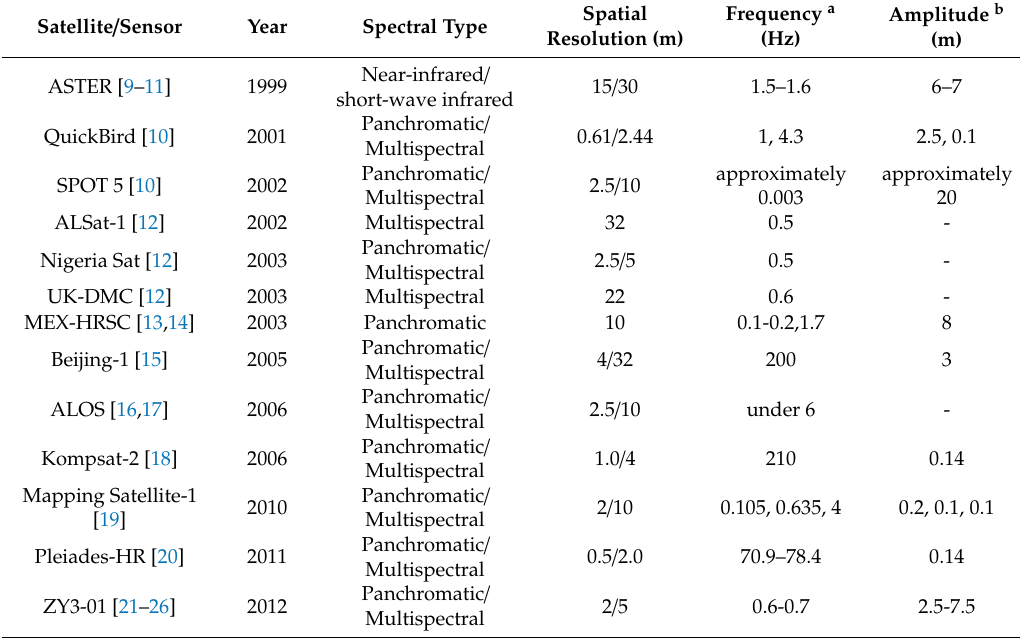
Table 1. Microvibration detection results for satellite platforms at home and